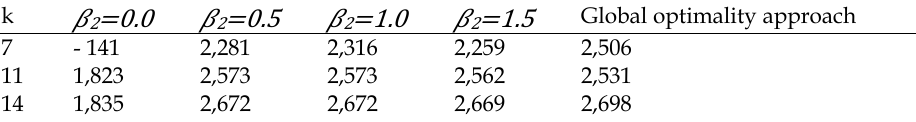
Table 1. Resulting improvement in social surplus for the Sioux Falls network.